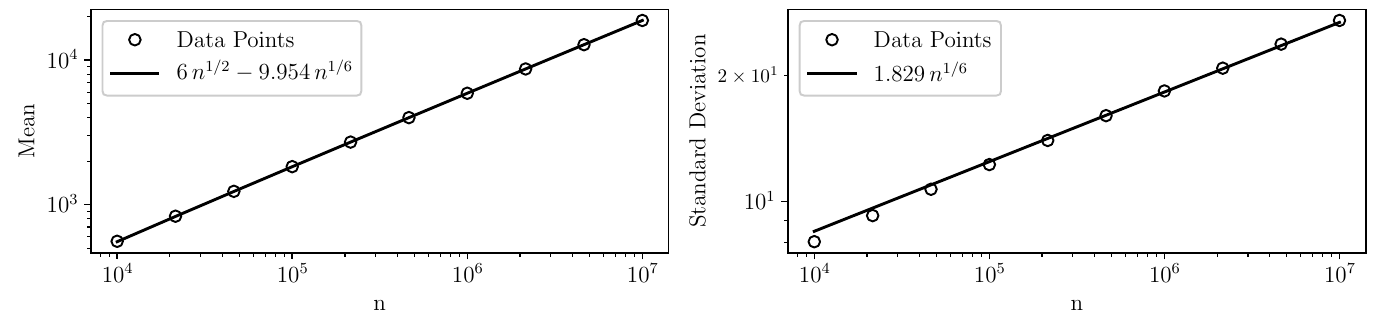
Figure 2: Log-Log plots of the best fits for the mean and standard deviation of the number of particles in three-aligned segments. The data indicate that E ( p I